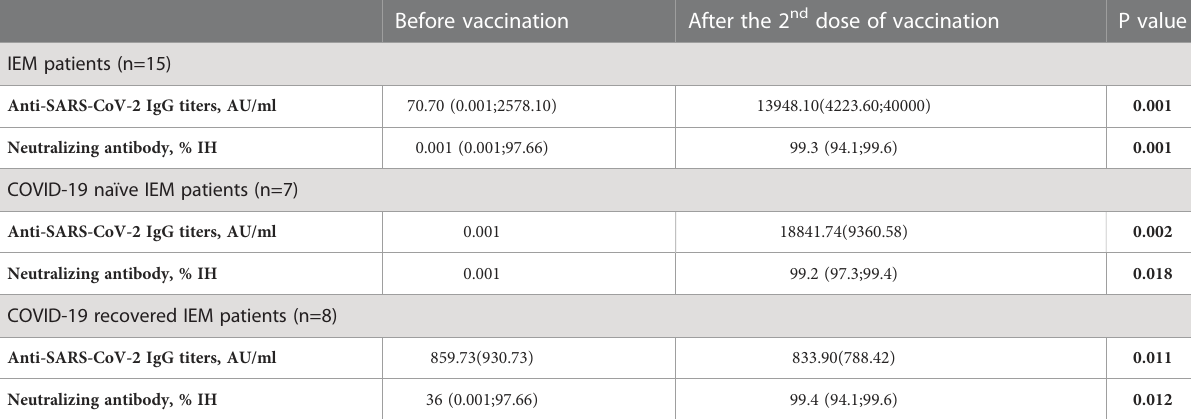
TABLE 4 Evaluation of Anti-SARS-CoV-2 IgG titers and neutralizing antibody IH% activity after the second dose of BNT162b2 vaccination in patients with inborn errors of metabolism. Before vaccination After the 2 nd dose of vaccination P value